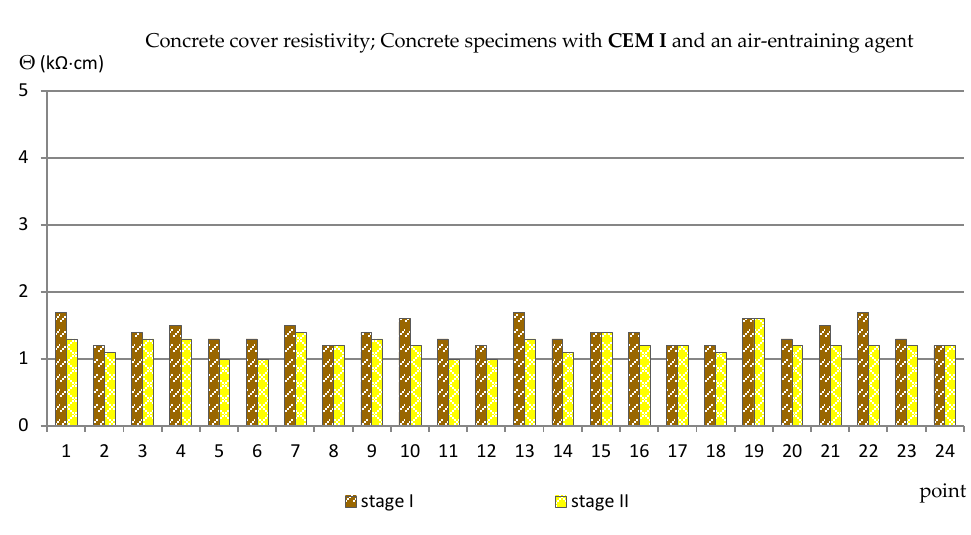
Θ = 1.0 ÷ 1.6 (k Ω · cm) (Figure 11).